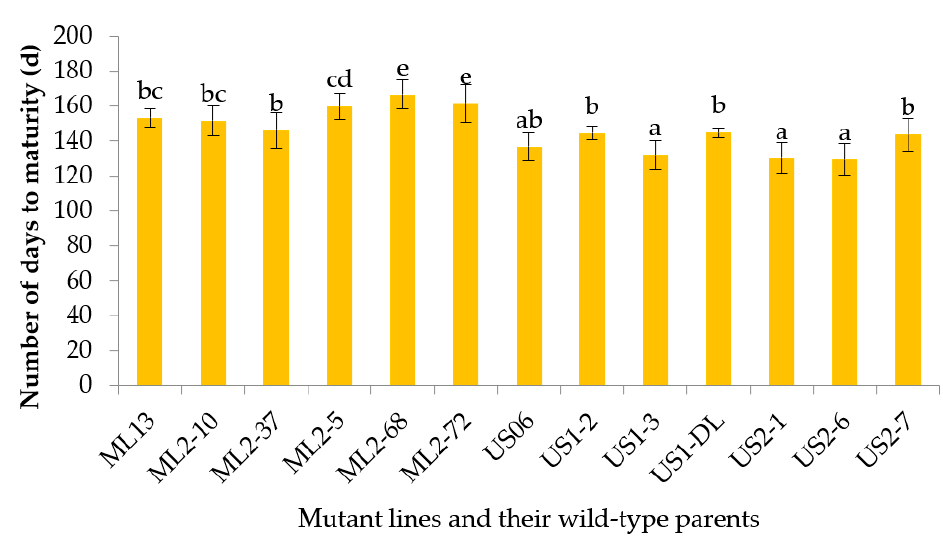
Figure 2. Number of days to maturity (NDM) in 11 sesame mutant lines and their two wildtypes (US06 and ML13). The superscript letters represent the groups according to Duncan’s test.